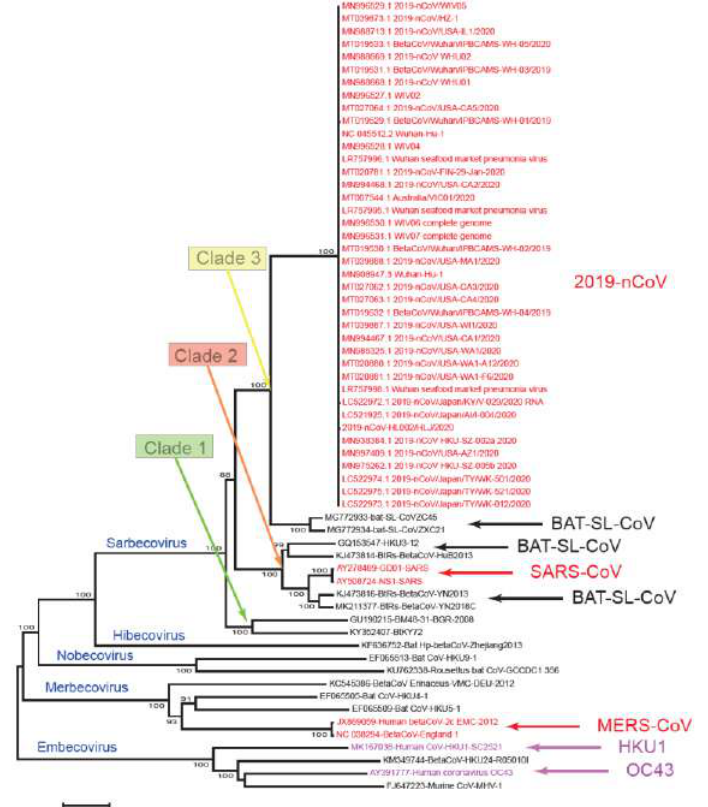
Figure 1. Phylogenetic analysis of the COVID-19 virus and its closely related reference